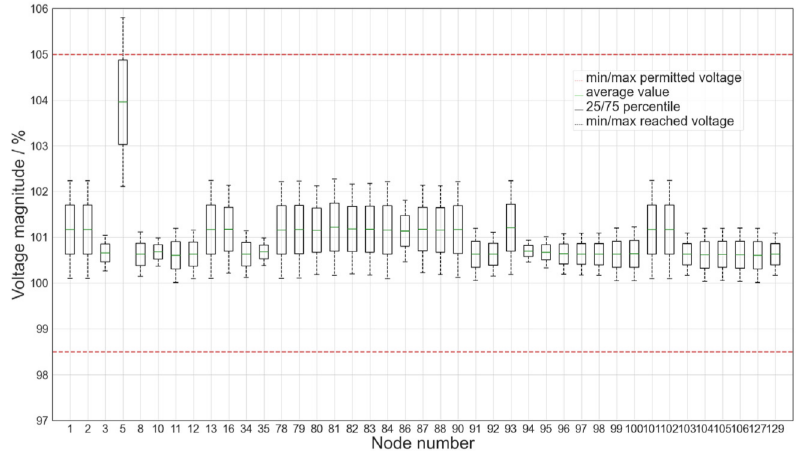
Figure 7. Voltage magnitude on some nodes of the MV grid after optimizing the voltage setpoint of the HV/MV